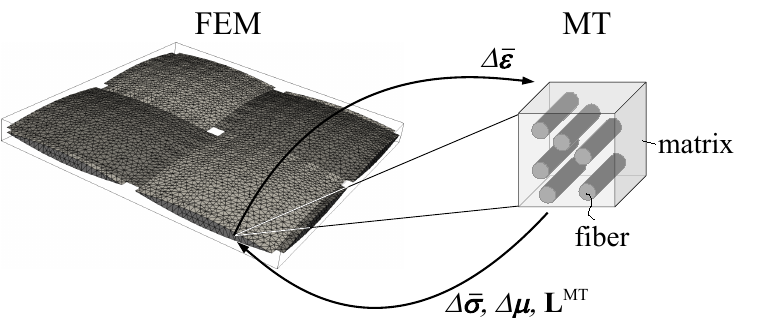
Figure 6. Graphical representation of two-scale computational scheme combining FEM at the level of textile ply and the MT method at the level of